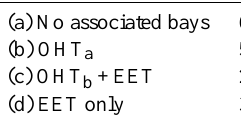
Table 5. Bays, associated or not, with 1h 0 F a events (number of